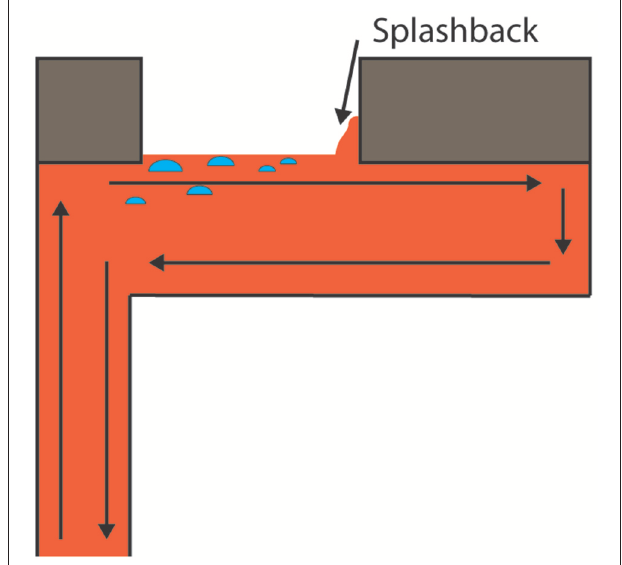
FIGURE 8 | An illustration of hypothetical lava lake behavior at Masaya. Arrows indicated possible directions of fluid flow. The deflection of rapidly ascending magma into a surface chamber could drive the processes measured at the surface, through the “window” available to observers.